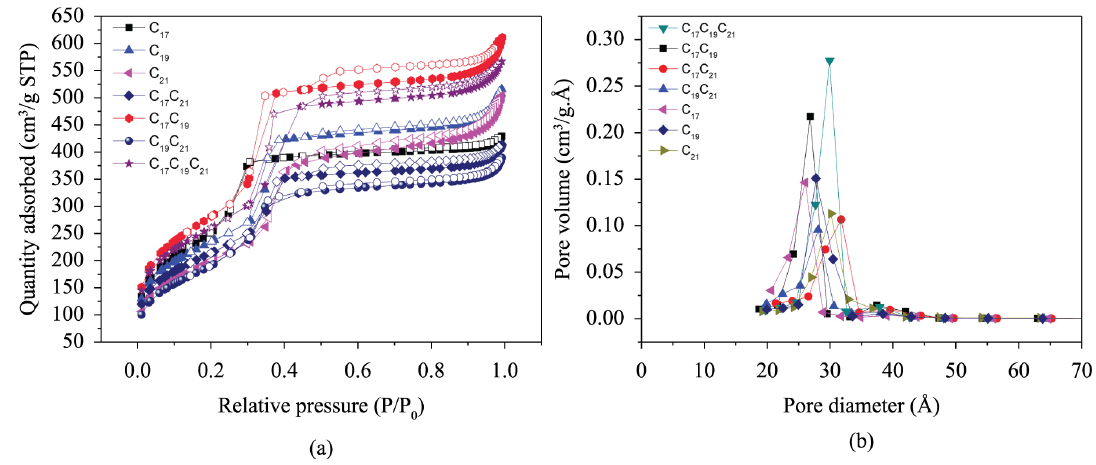
Figure 4. (a) Isotherms and (b) Pore distribution curves, based on the BET and BJH method, respectively.